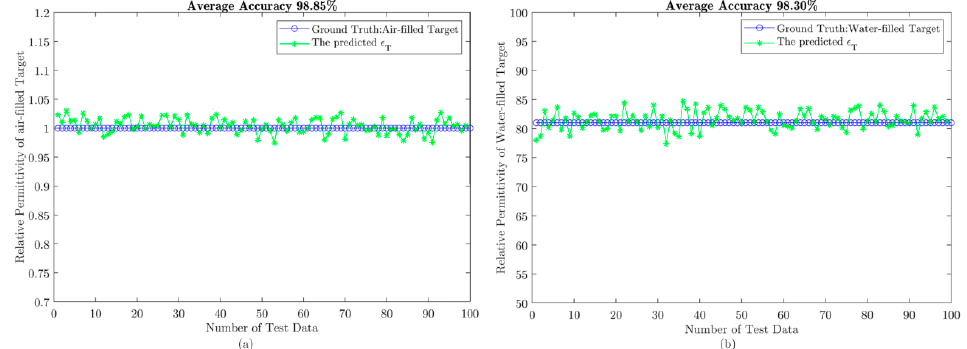
ε in layered media. ( a ) Air-filled target; ( b ) water-filled target. Figure 14. Results of estimating ε T in layered media. ( a ) Air-filled target; ( b ) water-filled target.